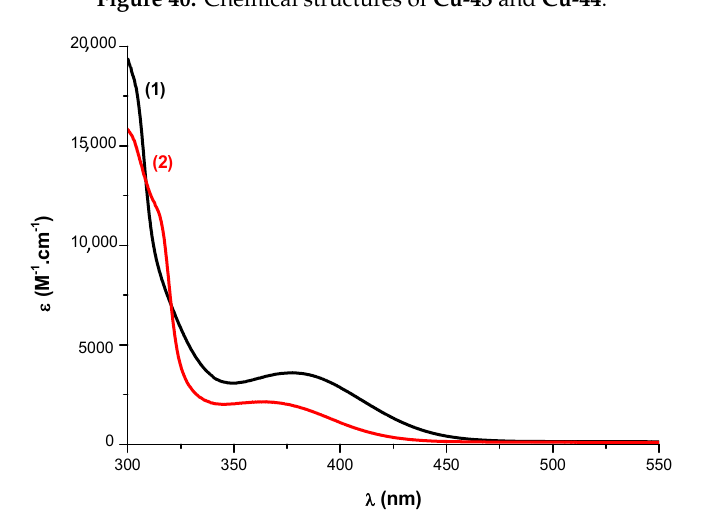
Figure 40. Chemical structures of Cu-43 and Cu-44 .